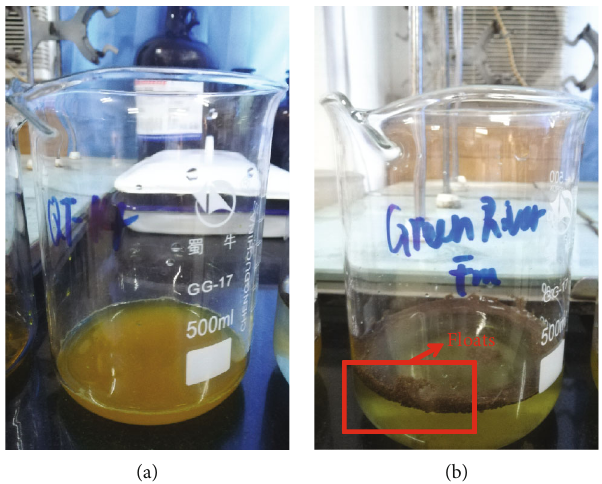
Figure 8: Acid treatment products for samples of high maturity level (a) and low maturity level